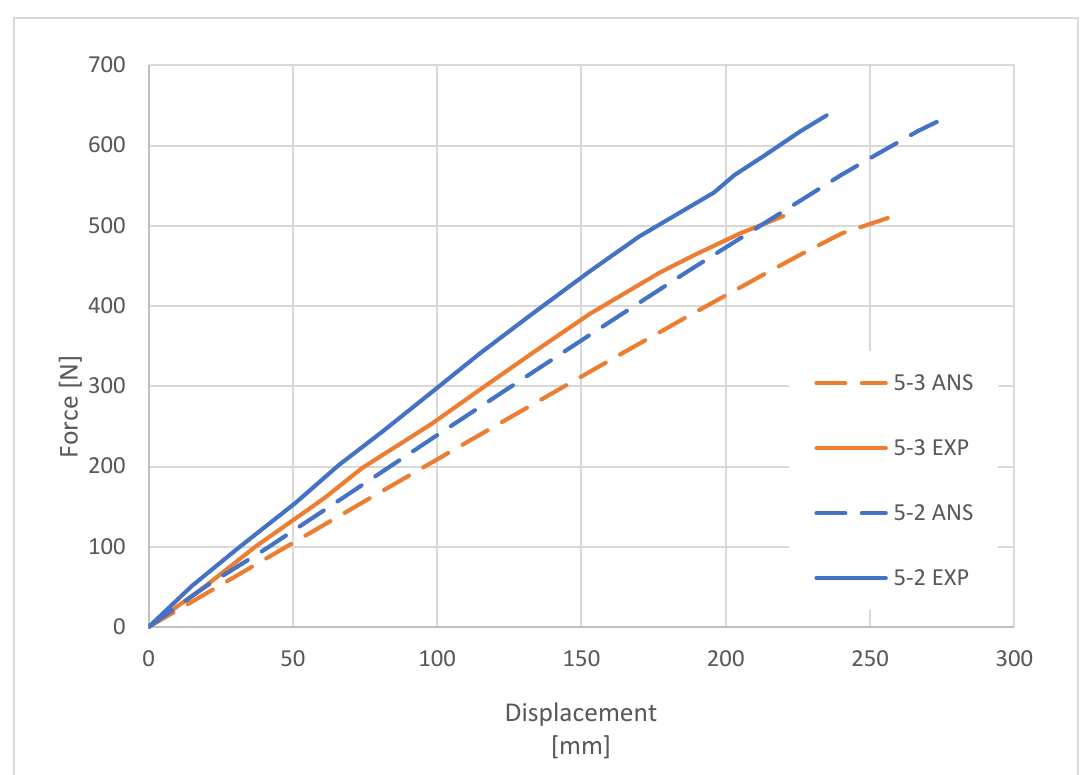
Figure 9. Load – deflection curves for 5 m long poles.